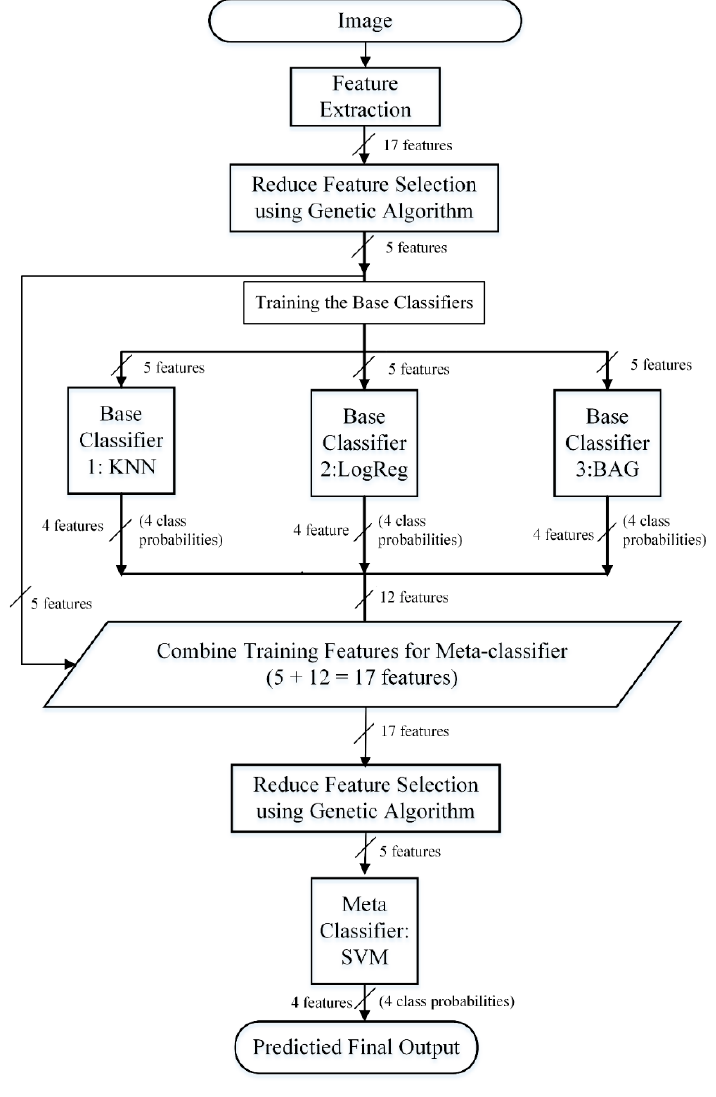
Figure 9. The overall design and development of the final model, SM1, which is a four-class classification framework. The input of the model is a brain image, and outputs are the probabilities of the four classes: epidural hemorrhage, subdural hemorrhage, intraparenchymal hemorrhage, and normal or healthy brain. Table 5. Comparison of AIBH with existing Al-Ayyoub et al.